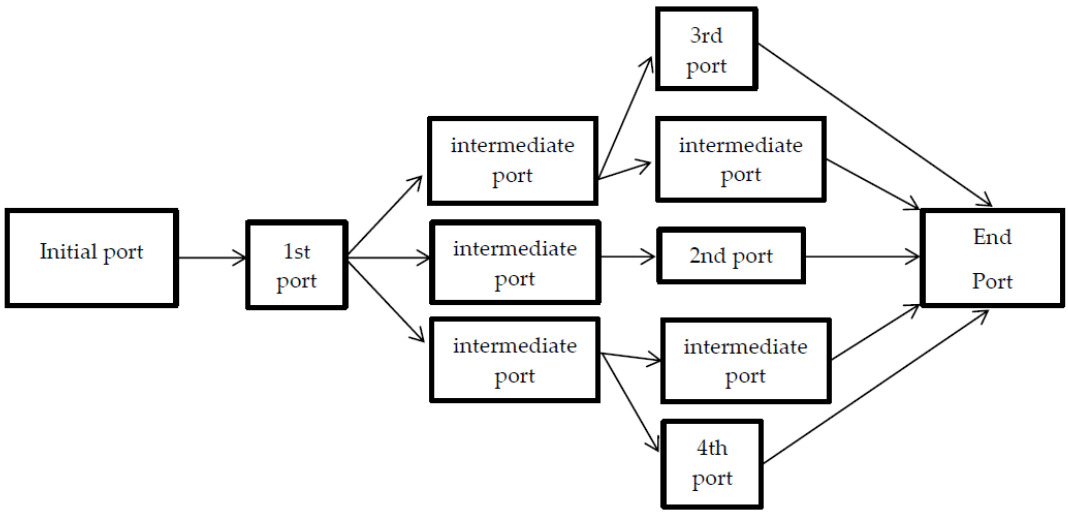
Figure 1. Cargo transportation diagram for the transport problem.